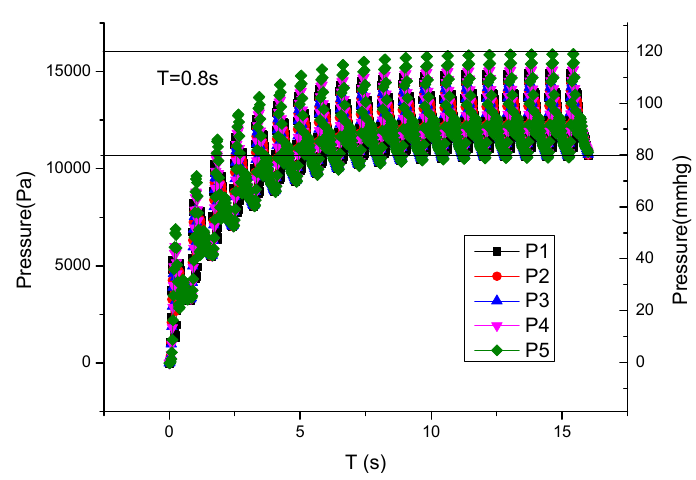
Figure 6. Changing process of pressure in the tube from static flow field (P1–P5 are five measuring points distributing axially along the tube).